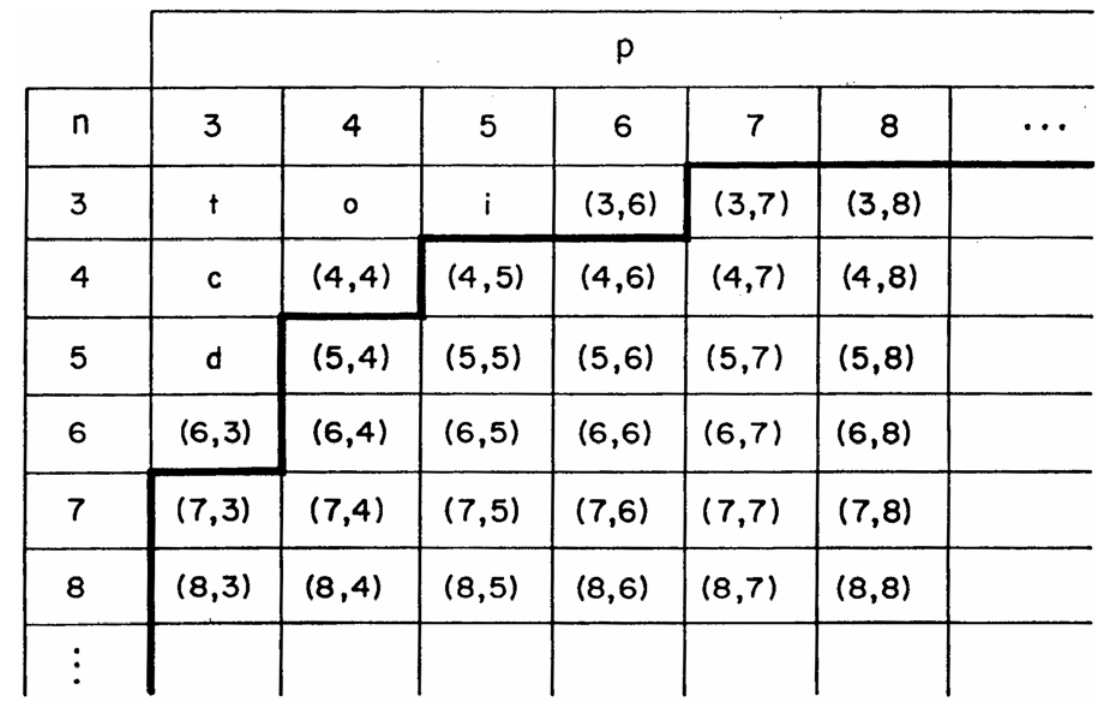
Figure 3. Topology map of regular